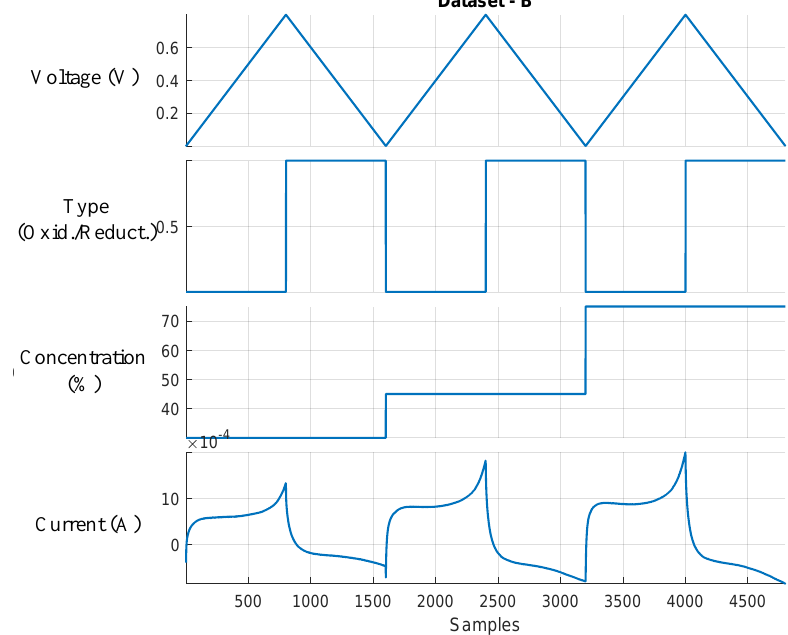
Figure 3. Distribution plot of Dataset